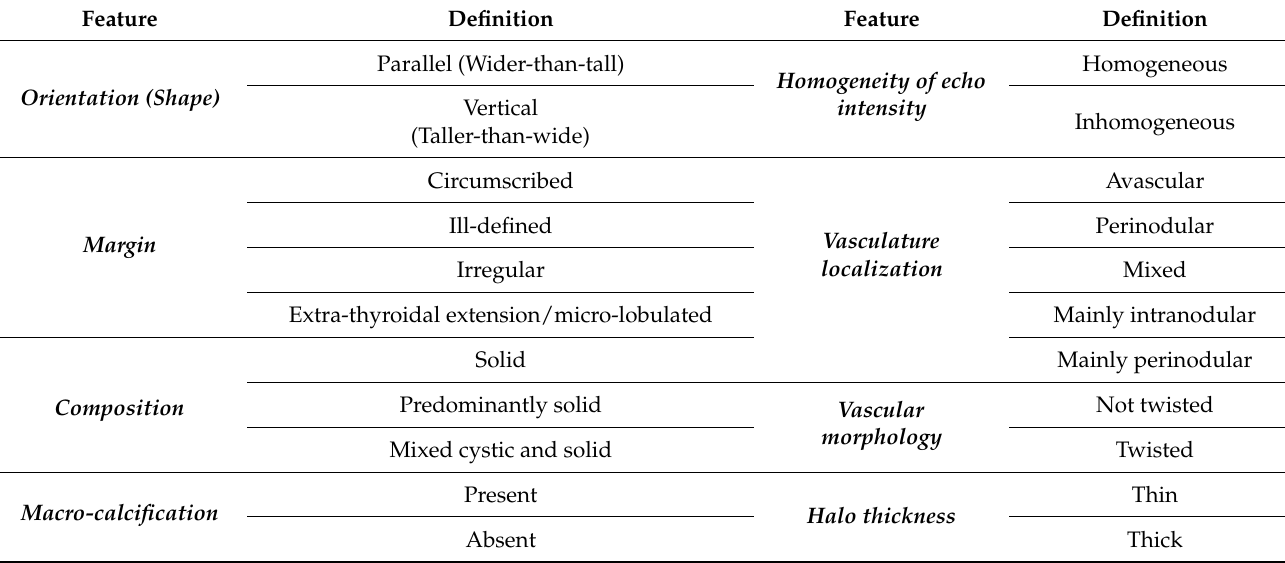
Table A1. Our defined candidate features (TIRADS+) of thyroid nodules in ultrasound images to establish a clinically relevant HAIbrid-TIRADS. The features shown in light gray are extra features defined with the aim to identify new potentially useful features for thyroid